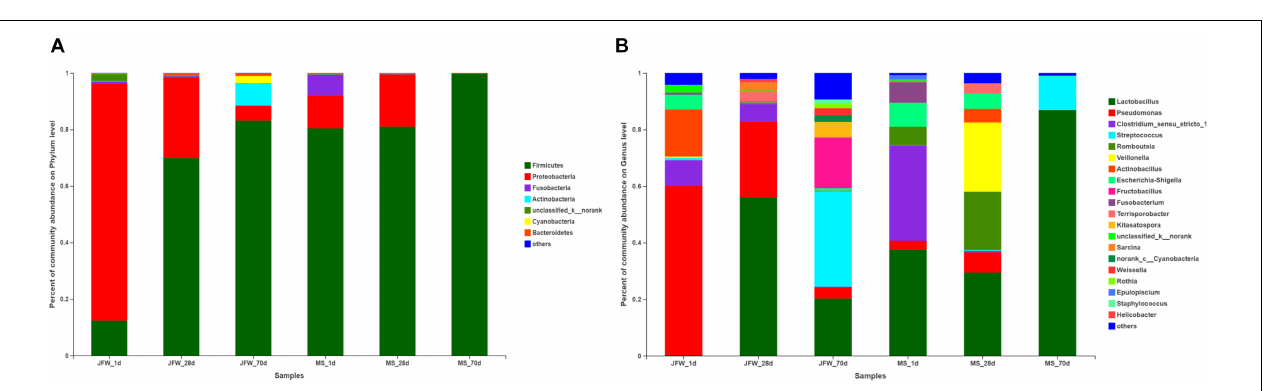
FIGURE 5 | Characterization of ileum microbiota from Jinfen White and Mashen piglets. (A) Microbial community bar plot of phyla in piglet ileum. (B) Microbial community bar plot of genera in piglet